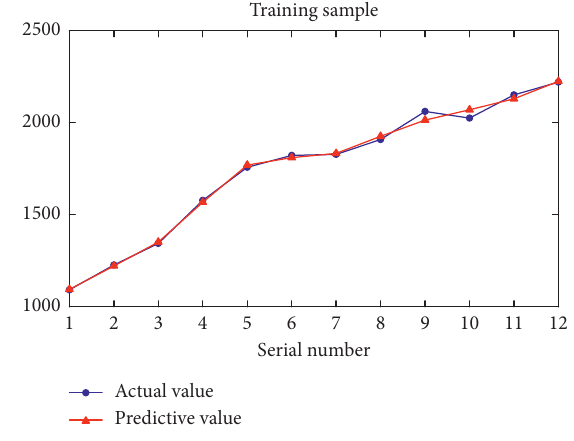
Figure 10: PSO-BP network training